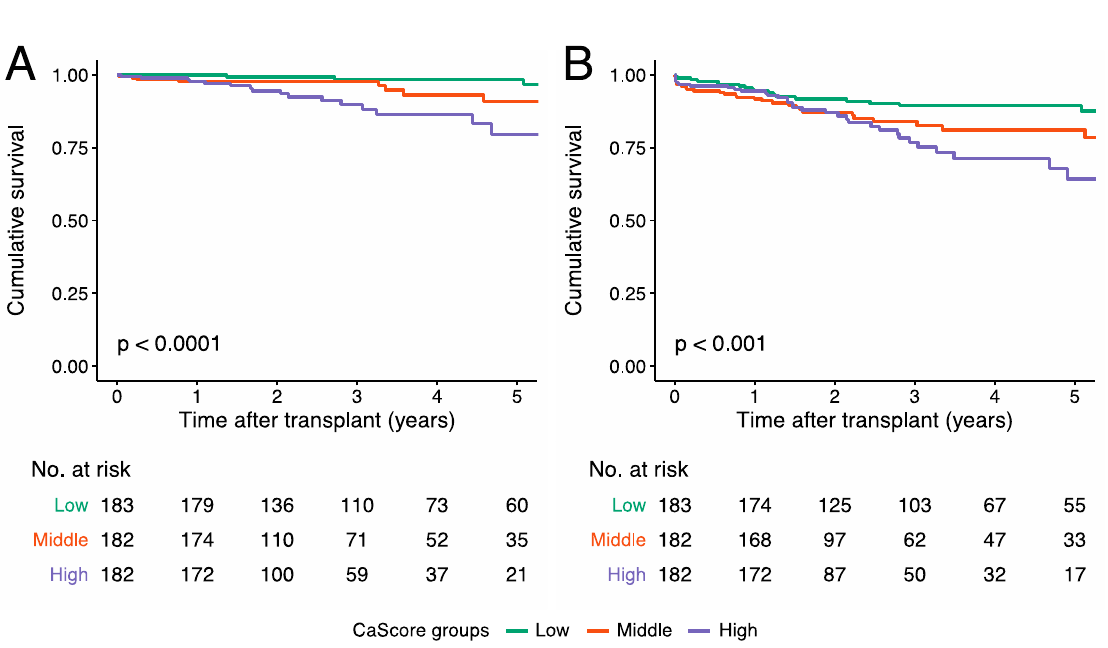
Figure 4. Kaplan-Meier curve for ( A ) cardiovascular survival and ( B ) cardiovascular event-free survival for the low aorto-iliac CaScore tertile, the medium CaScore tertile, and the high CaScore tertile. The cardiovascular survival at the median follow-up time was 98.5% (95% CI 96.4–100.0) in the low, 96.3% (95% CI 92.8–99.9) in the medium, and 86.4% (95% CI 79.5–94.0) in the high CaScore tertile. The cardiovascular event-free survival at the median follow-up time was 89.3% (95% CI 84.6–94.4) in the low, 81.0% (95% CI 74.2–88.5) in the medium, and 75.2% (95% CI 67.0–85.5) in the high CaScore tertile.